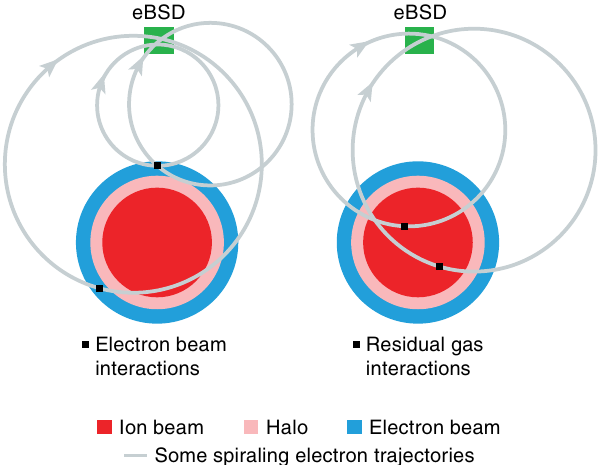
FIG. 20. Schematic illustration of the potential use of eBSDs for monitoring the halo of an intense ion beam. The beam propagates in a direction perpendicular to the plane of the figure. The electrons generated by the interaction of the ions with the hollow electron beam spiral along the magnetic field towards the detector generating a counting rate approximately proportional to the overlapped halo intensity (left). The ion beam interacting with the residual gas produces a background (right). Excellent vacuum is required to minimize this background (see